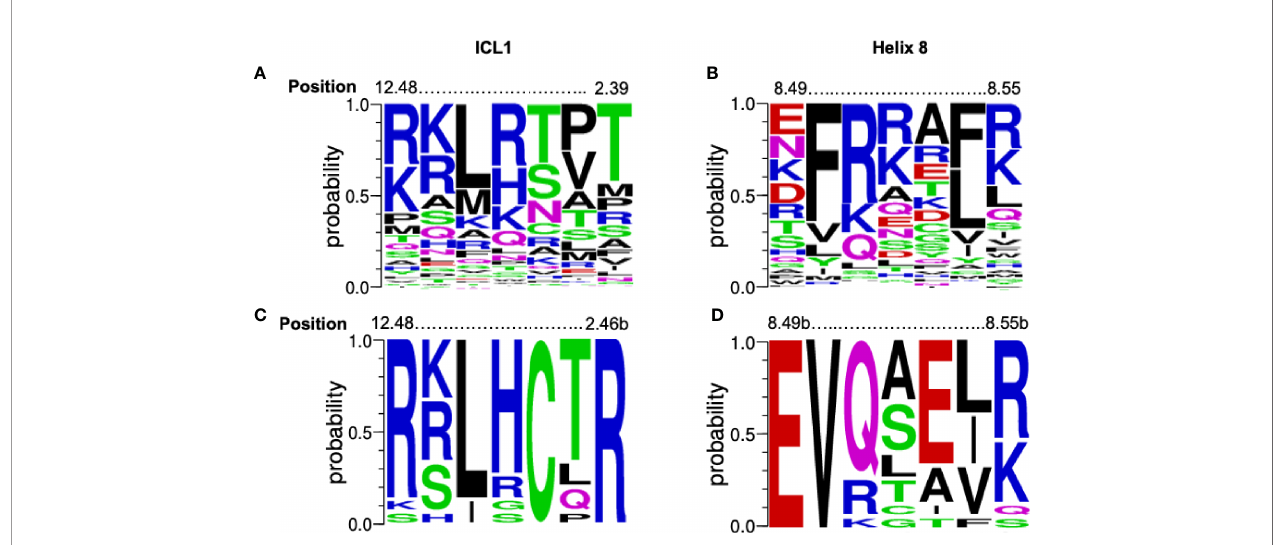
FIGURE 1 | Conservation of the [K/R]KL[R/H]xx[T/R] and EFxxxL motifs. Alignment of the amino acids from 298 human GPCRs (both Class A and B1) for (A) ICL1 and (B) Helix 8 depicted as a weblogo ’ s. Position marked using the Ballesteros-Weinstein numbering systems combined. Alignment of the amino acids from human Class B1 GPCR alone for (C) ICL1 and (D) Helix 8 depicted as a weblogo ’ s (45). Position marked using the Wootten Class B1 numbering, (46). The height of each letter represents the frequency of each amino acid. Amino acids are colour coded to their chemical properties: polar amino acids (G,S,T,Y,C) are green, neutral (Q,N) are magenta, basic (R,K,H) are blue, acidic (D,E) are red, and hydrophobic (A,V,L,I,P,W,F,M) are black. Figures generated using